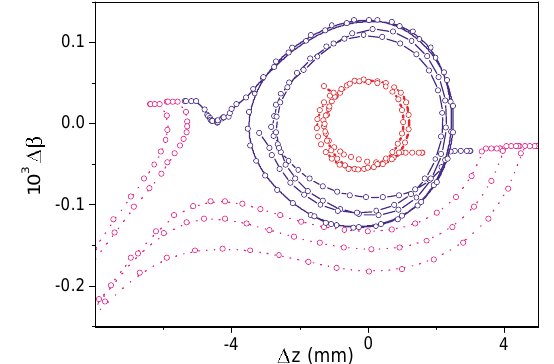
FIG. 5. (Color) Particle trajectories in the longitudinal phase space. The solid curves represent central trajectories and the dotted curves represent peripheral particles trajectories.